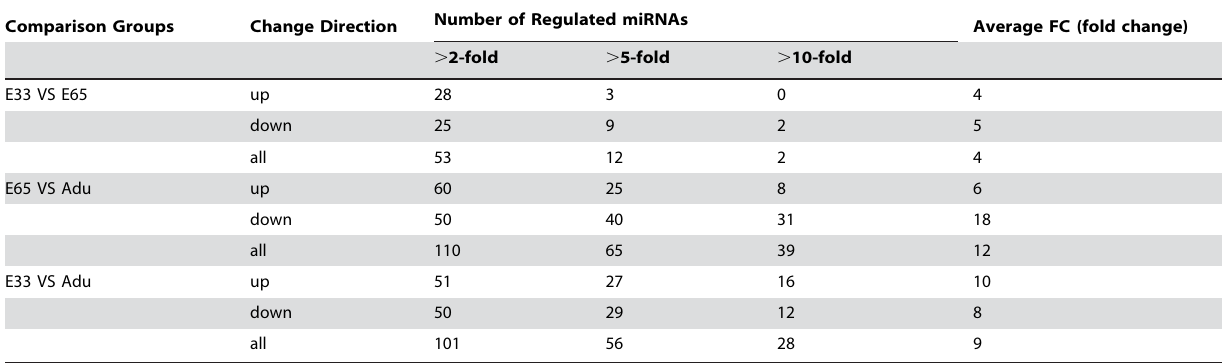
Comparison Groups